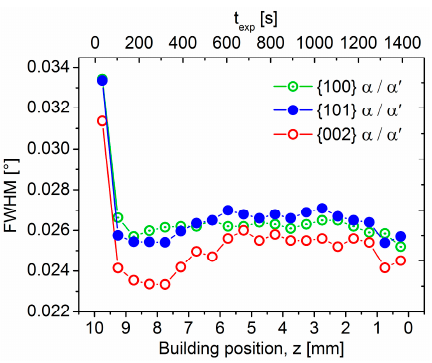
Figure 6. Evolution of the full width at half maximum (FWHM) for hcp {100}, {101} and {002} reflections of α ’/ α as a function of the building position z and exposure time t exp .